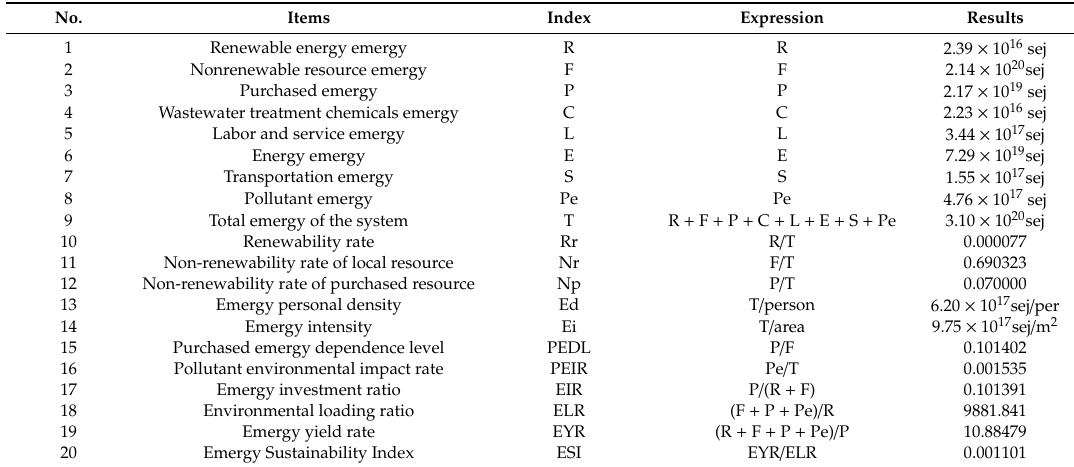
Table 11. Calculated results of ecological